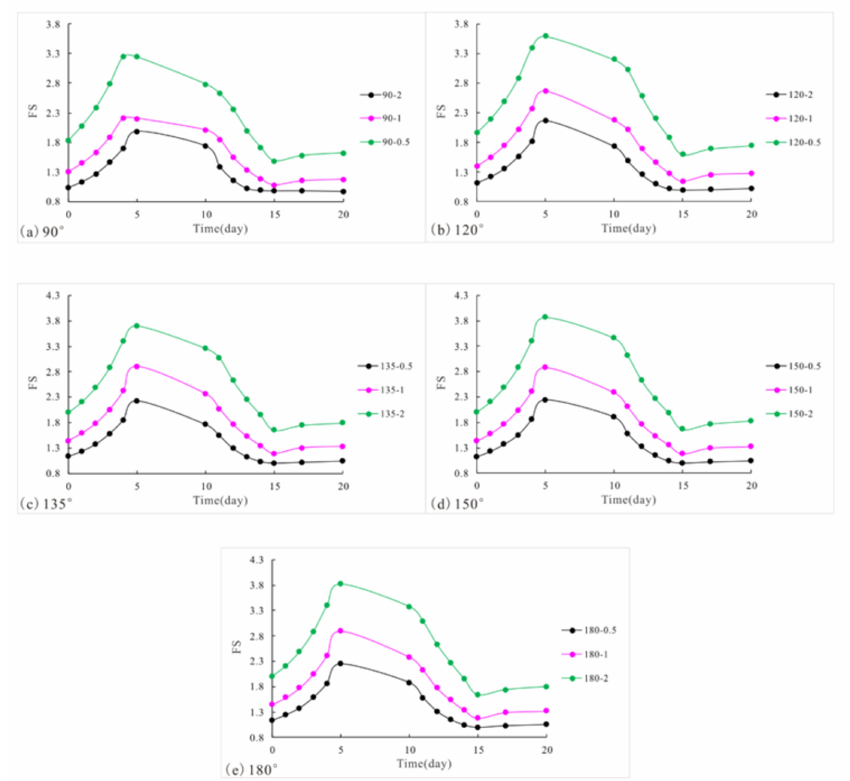
Figure 9. The di ff erence in safety factor between slopes with three gradients: ( a ) turning corner = 90 ◦ ; ( b ) turning corner = 120 ◦ ; ( c ) turning corner = 135 ◦ ; ( d ) turning corner = 150 ◦ and ( e ) turning corner = 180 ◦ .